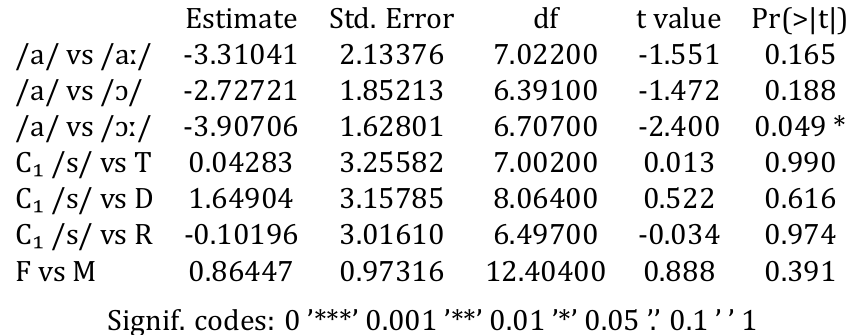
/aː/, /ɔ/, /ɔː/), and sex (two levels: female, male). As random effects, we had intercepts for speaker and word, as well as by-speaker random slopes for the effect of C₁ type.